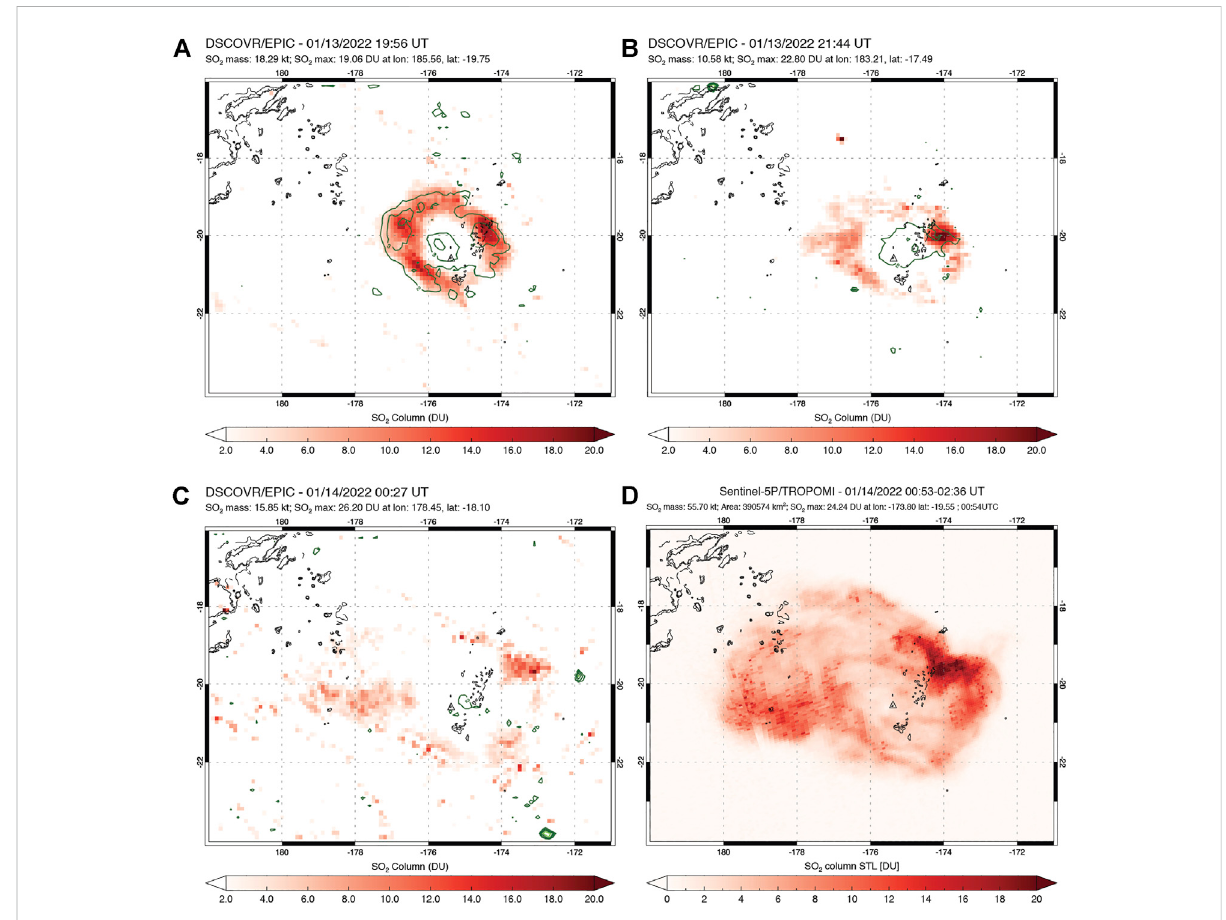
FIGURE 3 UVsatelliteobservationsofthe13January2022HTHH volcanicSO 2 cloudbyDSCOVR/EPICandTROPOMI. Greencontours in (A – C) showthe EPICUVAerosolIndex(UVAI),wherepositivevaluesindicateabsorbingaerosolssuchasvolcanicash(notethelowUVAIvaluesinthiscase;UVAI ≤ 3). (A) DSCOVR/EPICSO 2 dataat19:56UTC; (B) DSCOVR/EPICSO 2 dataat21:44UTC; (C) DSCOVR/EPICSO 2 dataat00:27UTConJanuary14; (D) S5P/ TROPOMI SO 2 data at 00:53 UTC on January 14. Scale: 1 ° in latitude/longitude corresponds to a distance of ~100